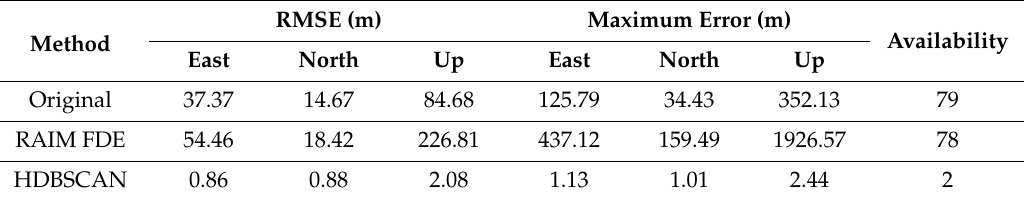
Table 5. Comparison of positioning accuracy and availability of D1b using different anomaly detection and exclusion methods.